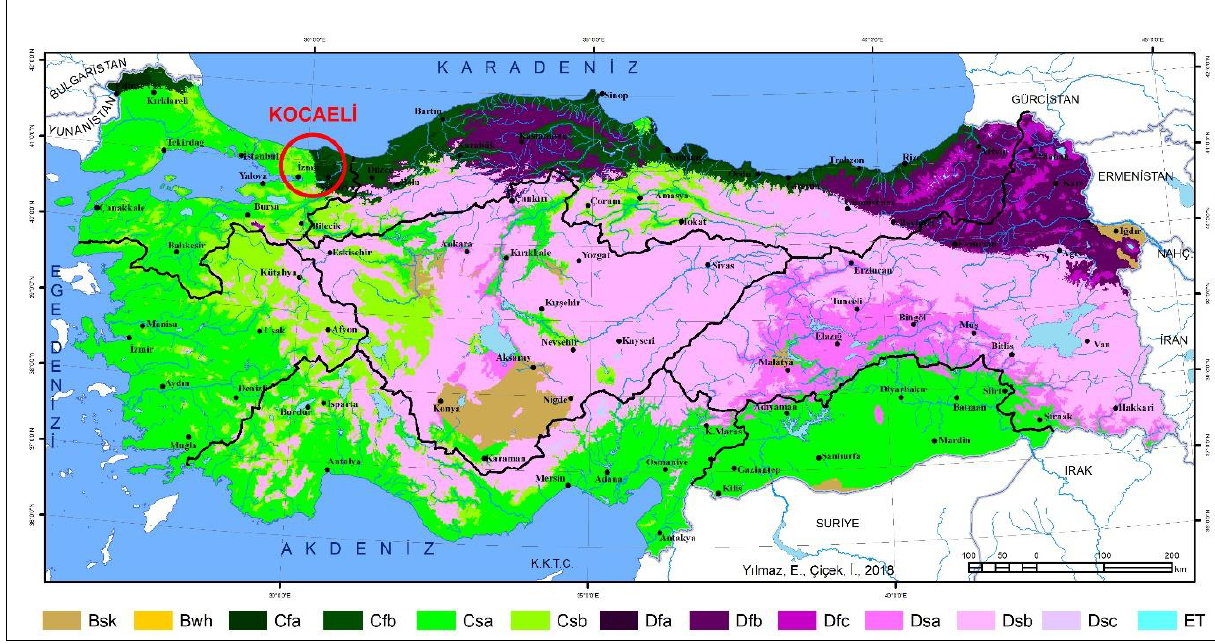
Figure 1. Köppen climate classification in